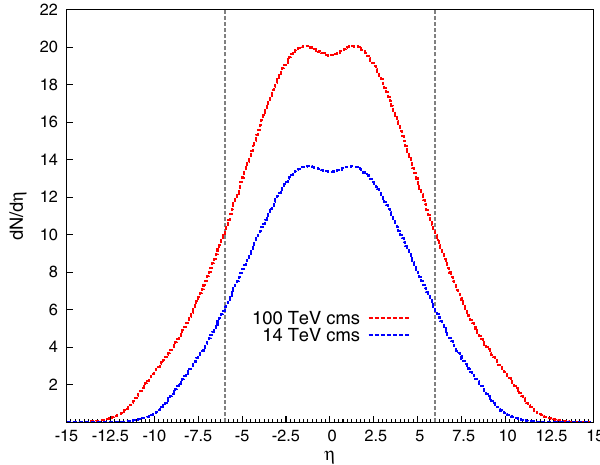
FIG. 3. Particle multiplicity as a function of pseudorapidity for 100 TeV p-p collisions in red and 14 TeV p-p collisions in blue at 5 mm from the nominal interaction point. The two vertical lines at η ¼ (cid:2) 6 show the detector acceptance.